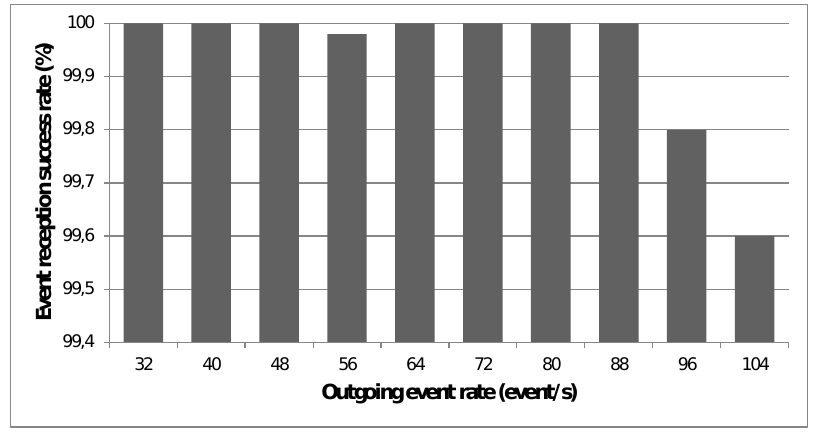
Figure 14. Event reception success rate registered for different outgoing event